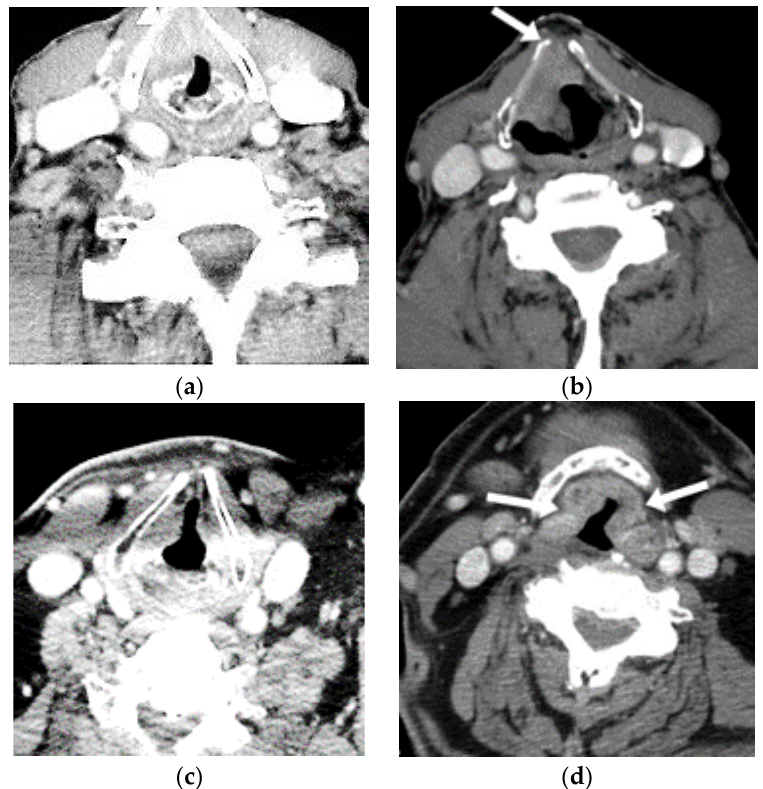
Figure 5. Illustrates the selected training and testing pictures. ( a ) Original training picture, ( b ) tested image with clearer white spots depicting laryngeal cancer, ( c ) original training picture, and ( d ) another tested picture with clearer white spots depicting laryngeal cancer.